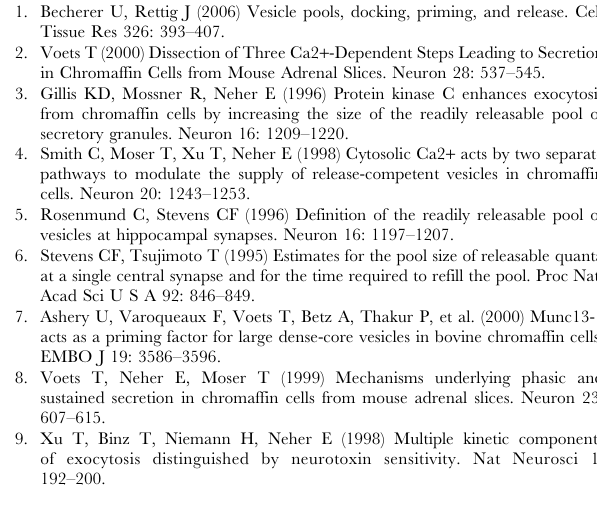
Figure S1 Vesicle-tracking algorithm (a). Image showing a typical chromaffin cell with vesicles marked by infection with pSFV1-IRES-Venus-NPY. Enlarged region (top right) shows a representative vesicle and the graph (bottom right) shows a 3D representation of the vesicle-intensity distribution. To prevent